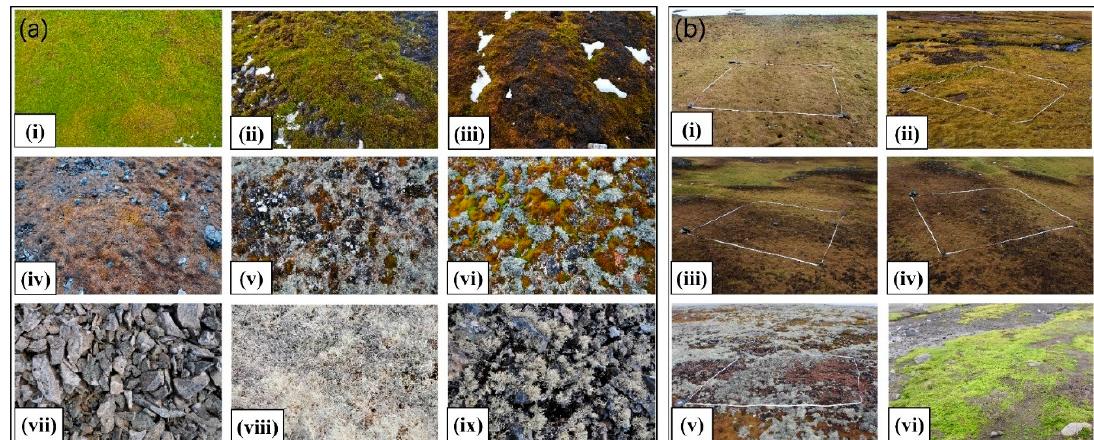
Figure 2. Examples of vegetation plots. ( a ) Plots collected in 2018: (i)–(iv): mosses in different health statuses, (v)–(vi): mixed mosses and lichens, (vii)–(ix): lichens. ( b ) Plots collected in 2019: (i)–(vi): plots of abundance measurement for mosses and lichens.